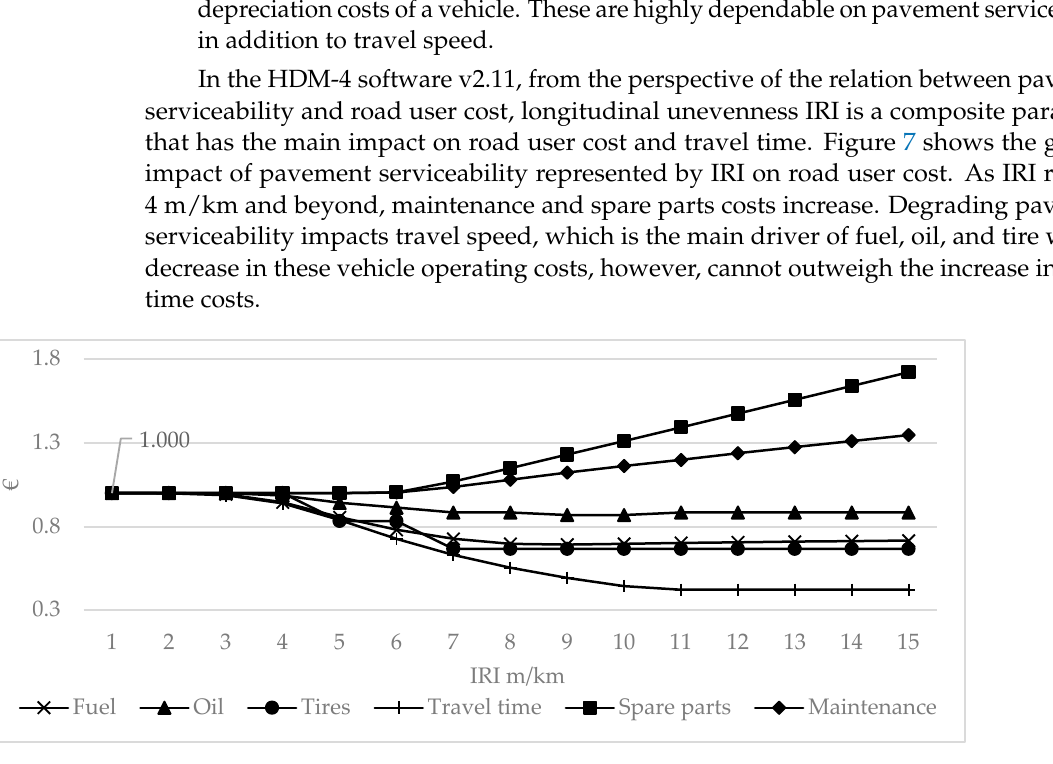
Figure 7. Road user cost related to IRI.